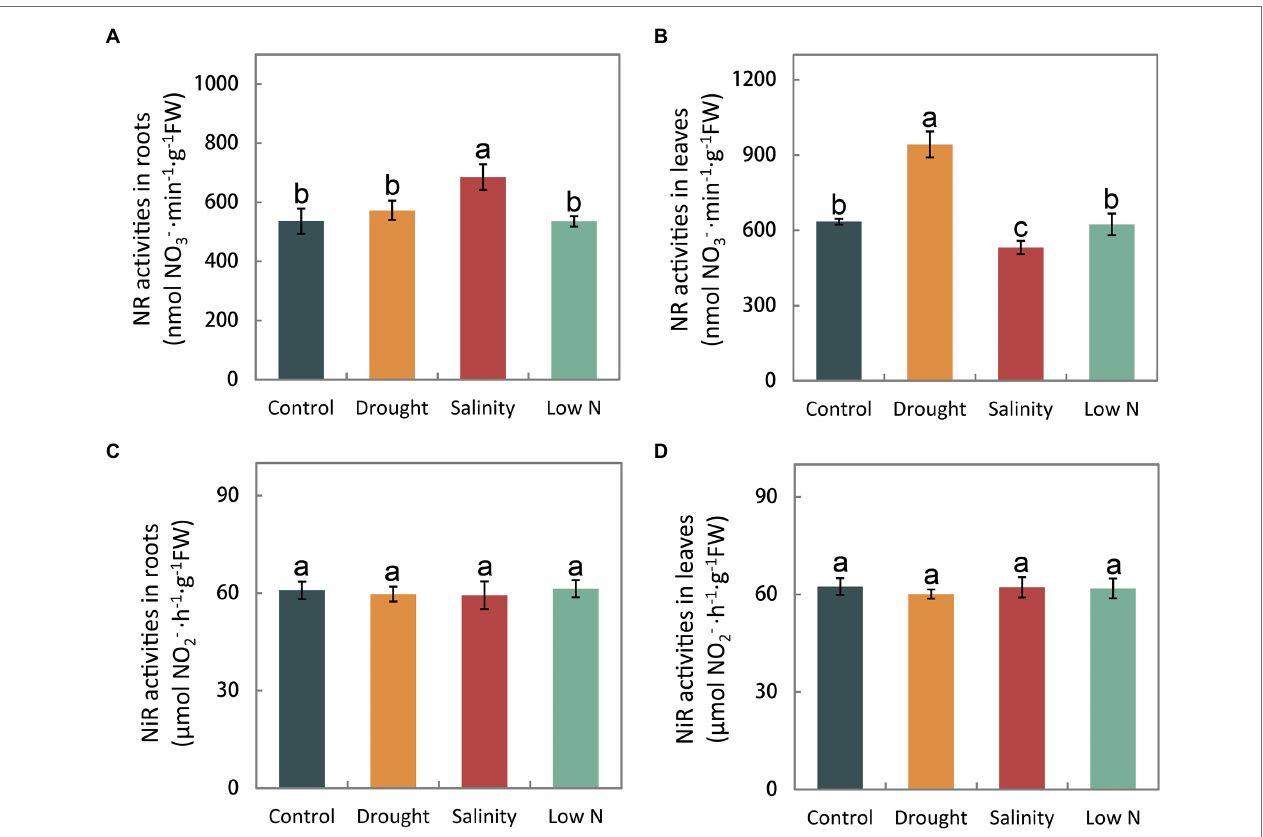
FIGURE 4 | Activities of nitrate reductase and nitrite reductase in roots (A,C) and leaves (B,D) of S. japonica as affected by drought, salinity, and low N treatment. Data indicate means ± SE of three replicates (12 plants). Bars labeled with different letters indicate significant differences between treatments ( p <